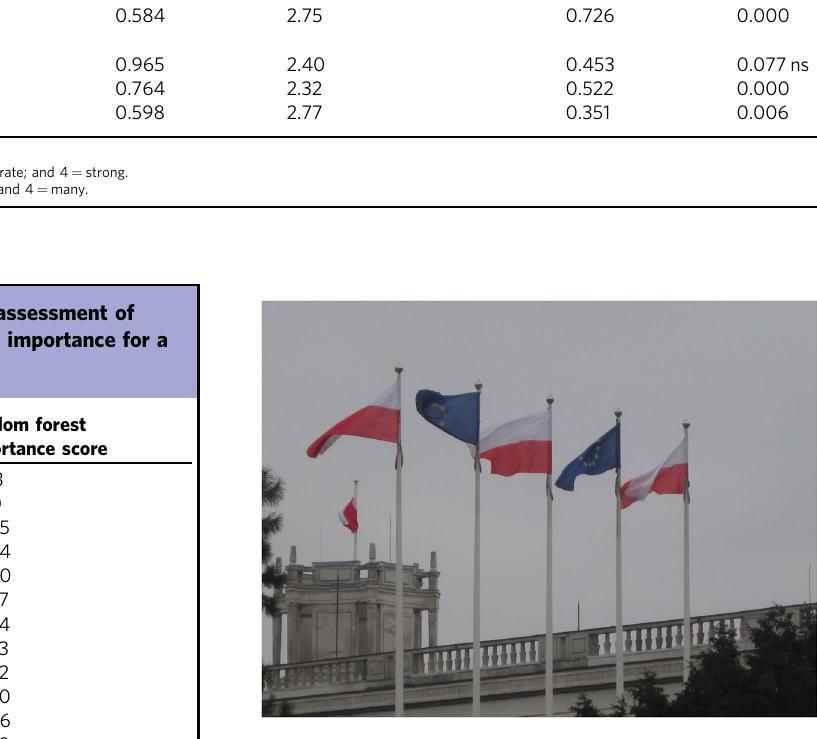
Fig. 3 Polish and European Union fl ags fl y side-by-side in Warsaw, symbolising the dual national and supranational identities within the European peace system. The development of an overarching socio-political identity is a notable feature of peace systems. Reproduced with permission of Douglas P. Fry; copyright © Douglas P. Fry, all rights